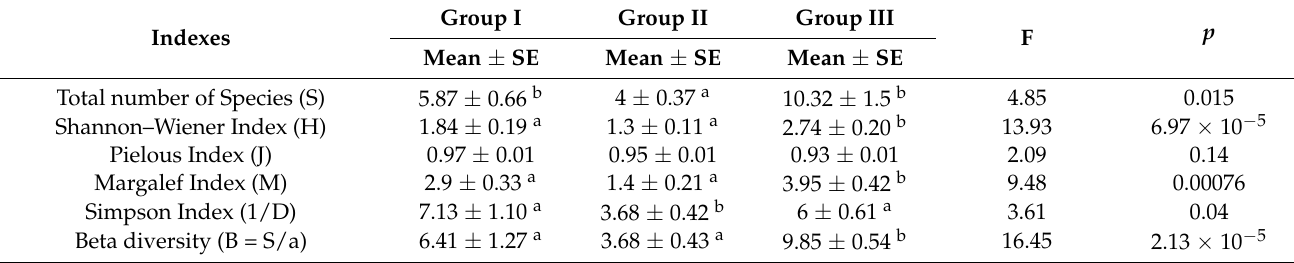
Table 3. Species richness and diversity indexes of oak-dominated forests of Swat, Pakistan.